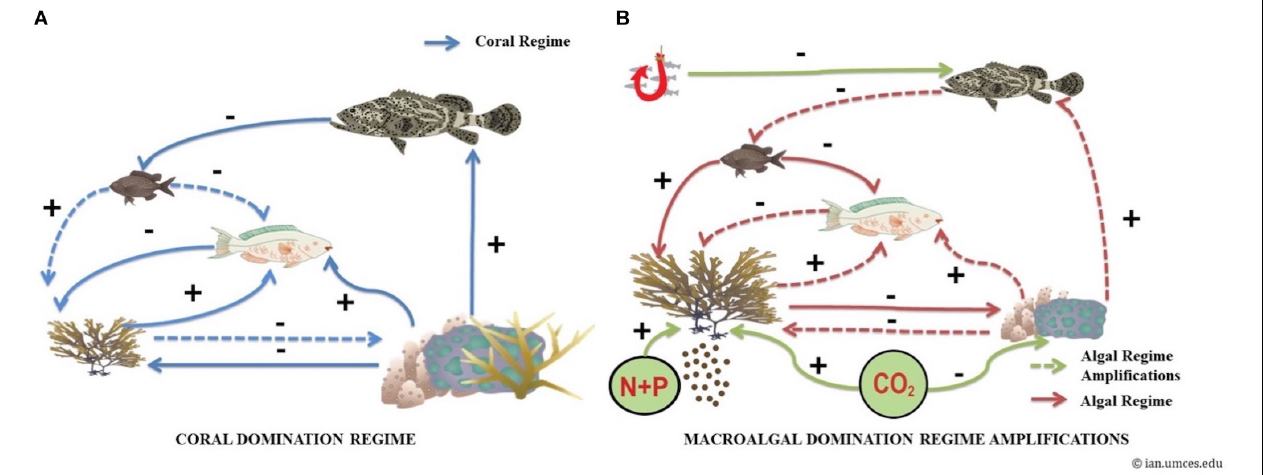
FIGURE 1 | Feedbacks and interactions in two different coral states in the Mesoamerican Reef (MAR); (A) coral state (left) and (B) stressed coral state (right). The signs represent (+) positive (mutualism or commensalism) and (–) negative (competitive or predation) effects. The solid arrows represent strong effects and the dashed arrows weak ones. Blue arrows describe the effects and feedbacks in a healthy coral state. Green arrows describe the drivers inducing a loss of coral reef resilience in the system when levels of CO 2 , nutrients (Nitrogen and Phosphorus: N+P) and fishing pressure (represented by a red fishhook) increase. Red arrows describe the stressed coral state effects and feedbacks, with a positive feedback loop between macroalgae, damselfish, and herbivorous fishes, amplifying coral reef resilience